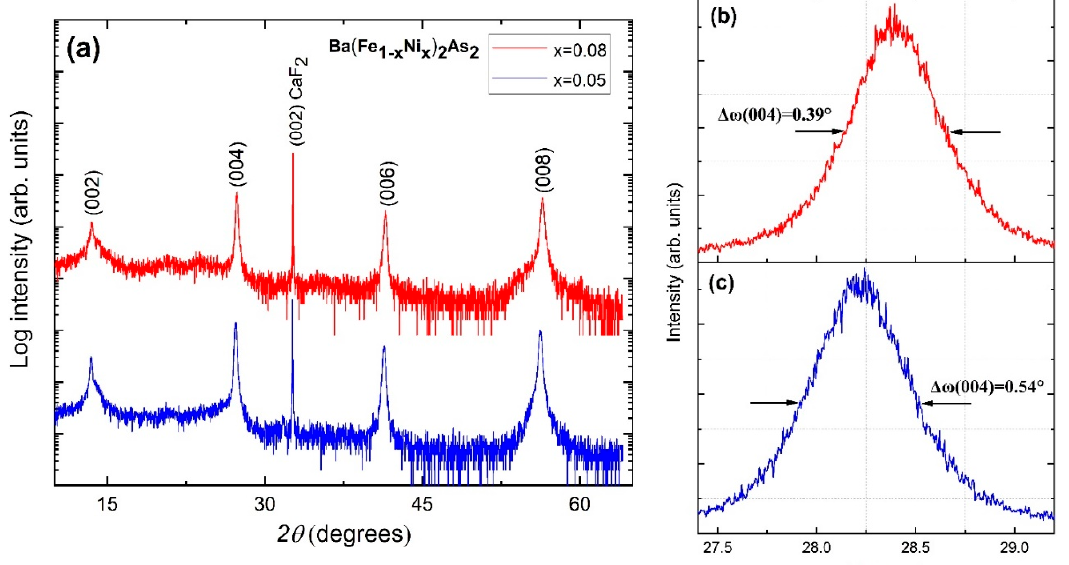
Figure 1. XRD patterns for Ba(Fe 1 − x Ni x ) 2 As 2 thin films grown on CaF 2 . ( a ) Standard θ –2 θ XRD scans; rocking curves with determined full width at half maximum (FWHM) values of the (004) reflection for films with a nominal Ni content of: ( b ) x = 0.05 and ( c ) x = 0.08. The lattice parameter in the basal plane increases for single crystals from a 0 = 3.9590 Å in undoped